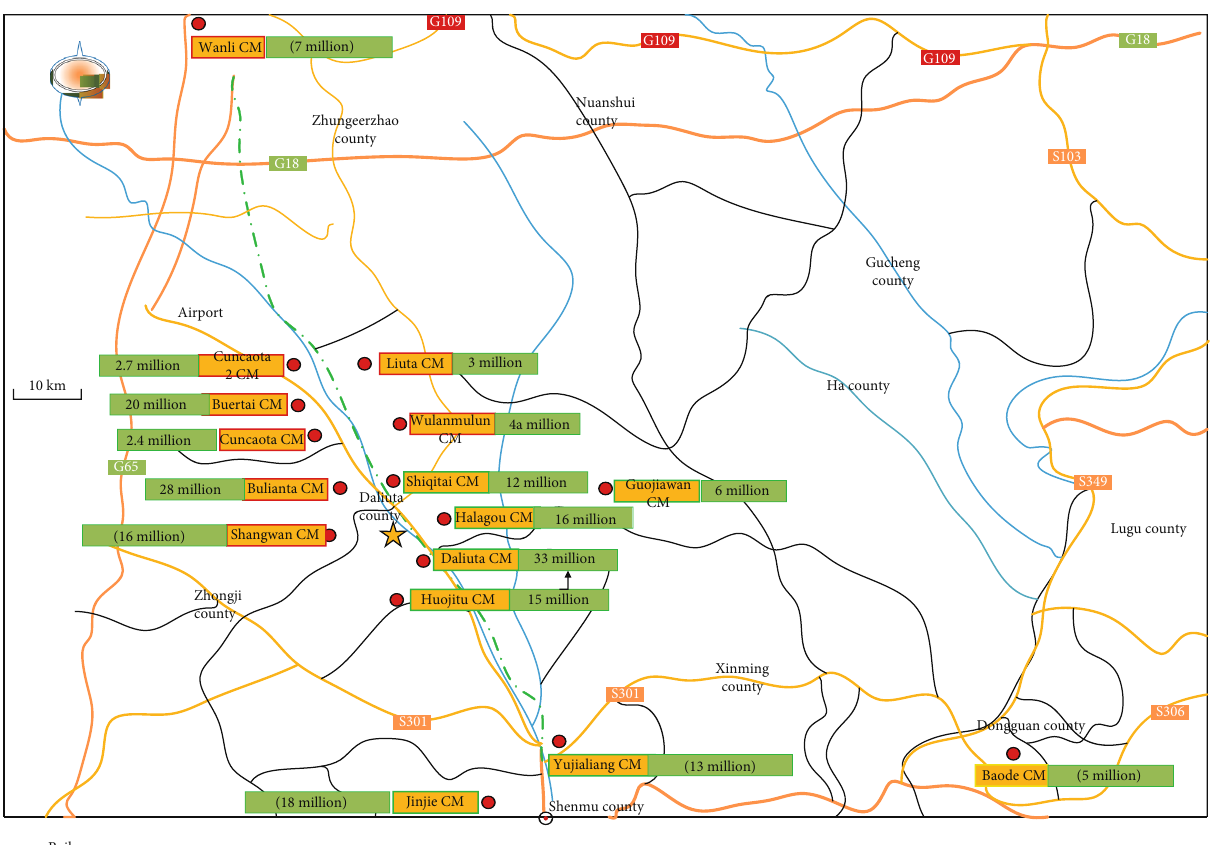
Figure 1: Location of Shendong mining